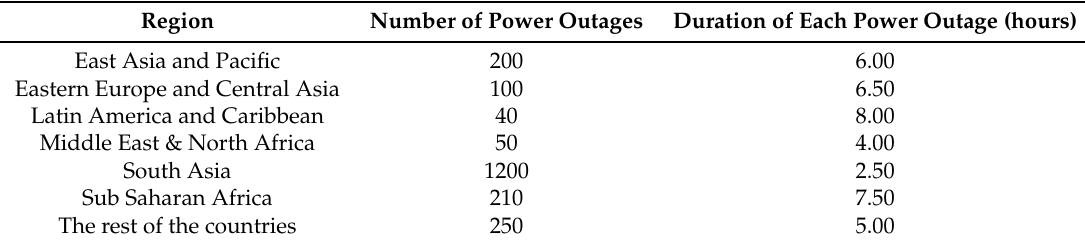
Table 3. Number of power outages recorded in different parts of world in 2011